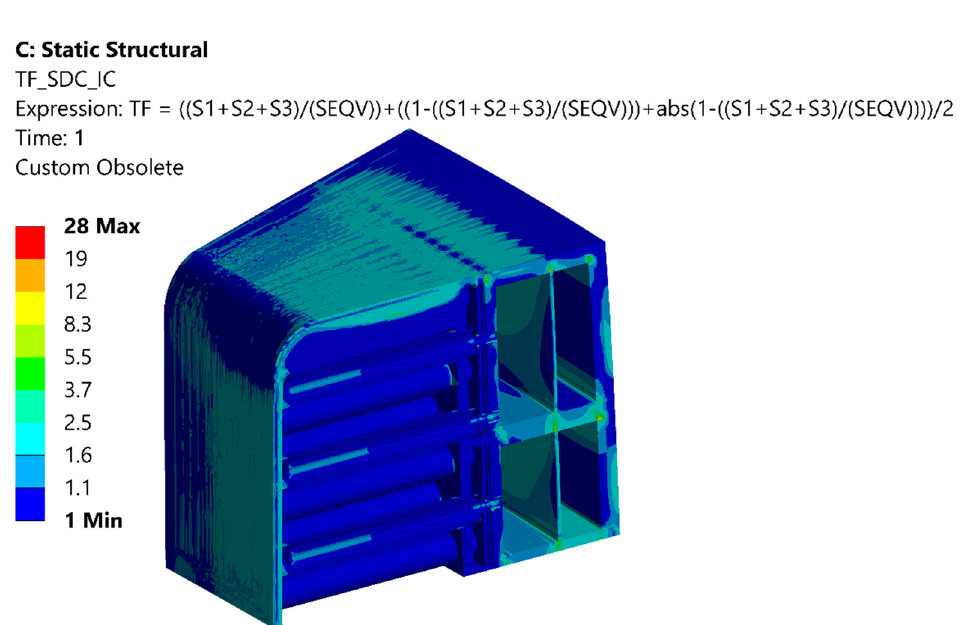
Figure 11. Stress triaxiality contour on BB cap region—inelastic